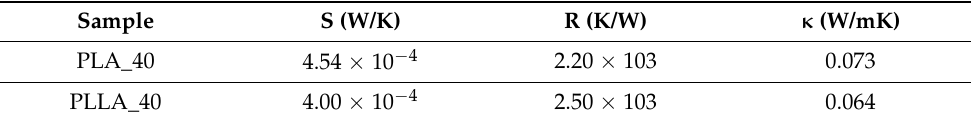
Figure 6. Melting endotherms of indium beads placed on PLA_40 and PLLA_40 microspheres. Table 4. Thermal resistivity and conductivity of microspheres